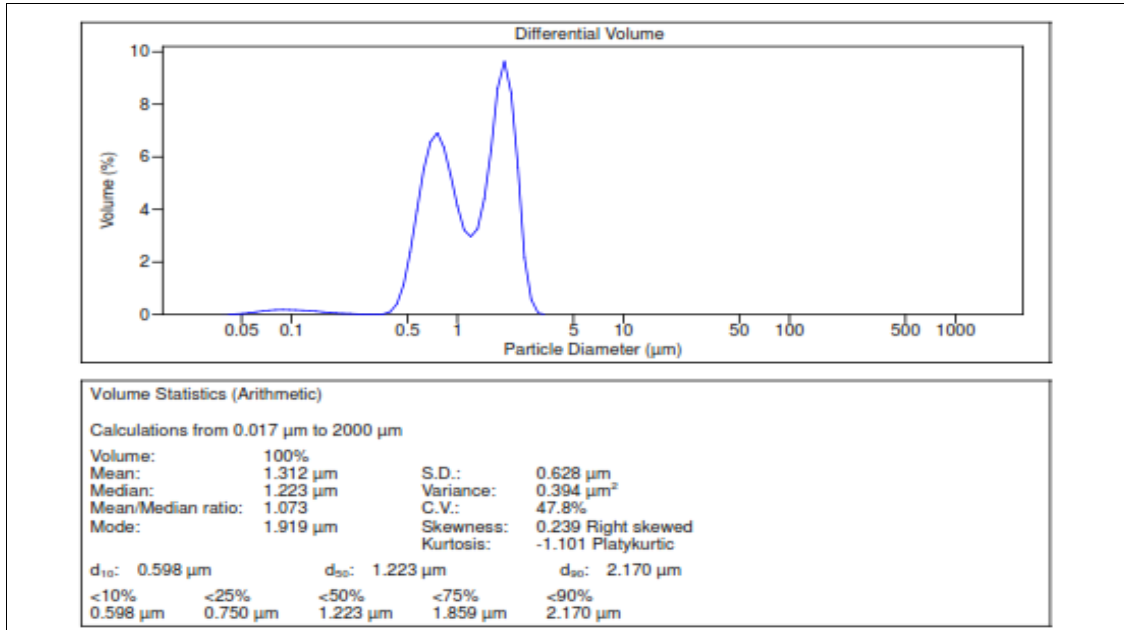
Figure 2. The particle diameter of the microcapsule measured with PSA (LS 13 320; Optical model: Fraunhofer.rf780d; fluid: H 2 O). Data are expresed as mean ± SD (n = 3). d 90 : the portion of particles with diameters below this value is 90%; d 50 : The portions of particles with diameters smaller and larger than this value are 50%; d 10 : the portion of particles with diameters smaller than this value is 10%. Span = (d 90 – d 10 )/d 50